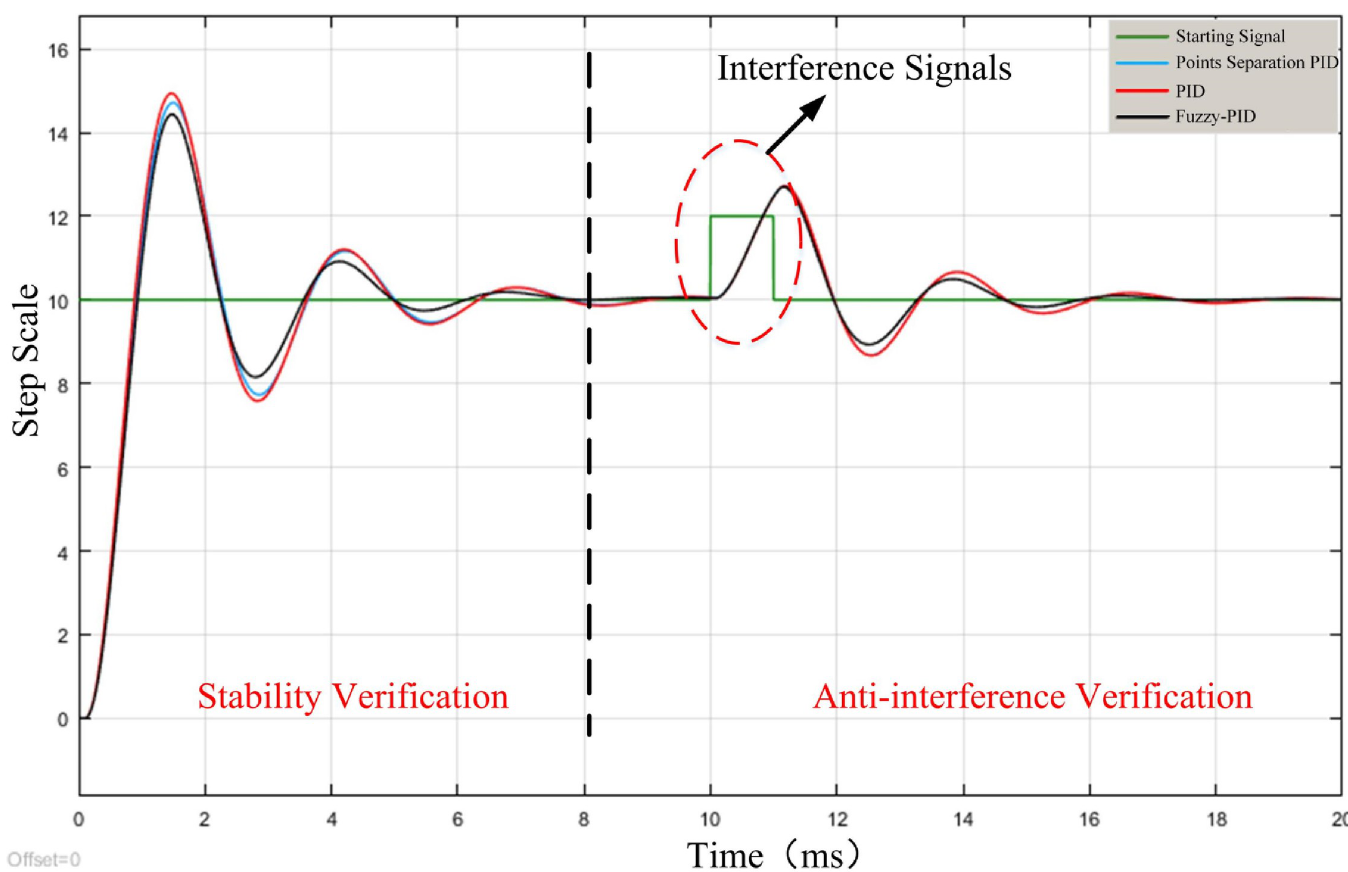
Fig 12. Small interference signal